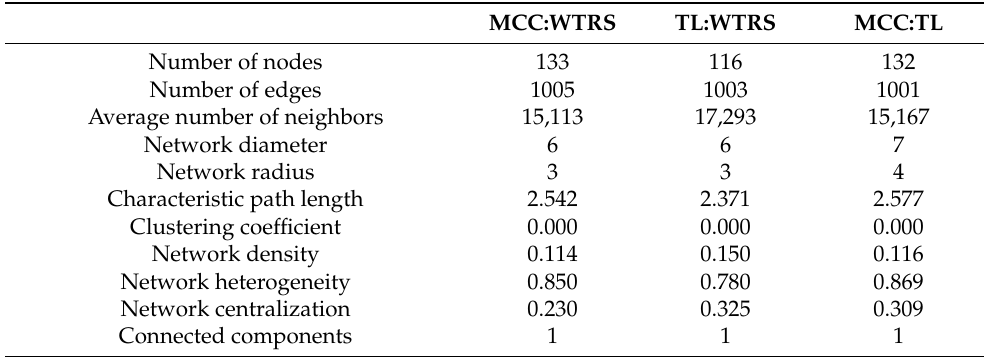
Figure 3. Co-presence network for the couples: ( a ) tomato landraces:wild tomato related species, ( b ) modern commercial cultivars:tomato landraces, ( c ) modern commercial cultivars:wild tomato related species. Node sizes reflect average relative abundance of each KEGG module. The line thickness is proportional to the edge weight. Node colors: green for wild tomato related species, blue for tomato landraces and red for modern commercial cultivars. Table 3. Topological properties of pairwise functional networks. WTRS: wild tomato related species; TL: tomato landraces; MCC: modern commercial